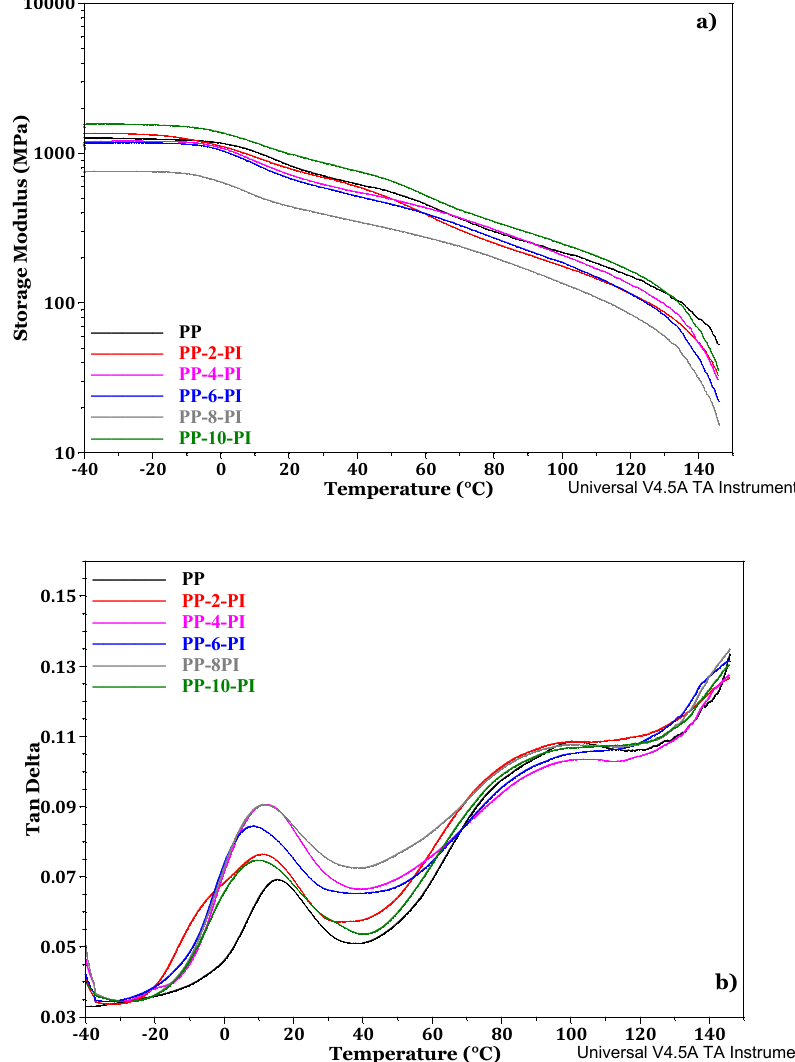
Figure 6. DMA thermograms for PP and PP-PI composites. ( a ) Storage modulus versus temperature, and ( b ) tan δ versus temperature.